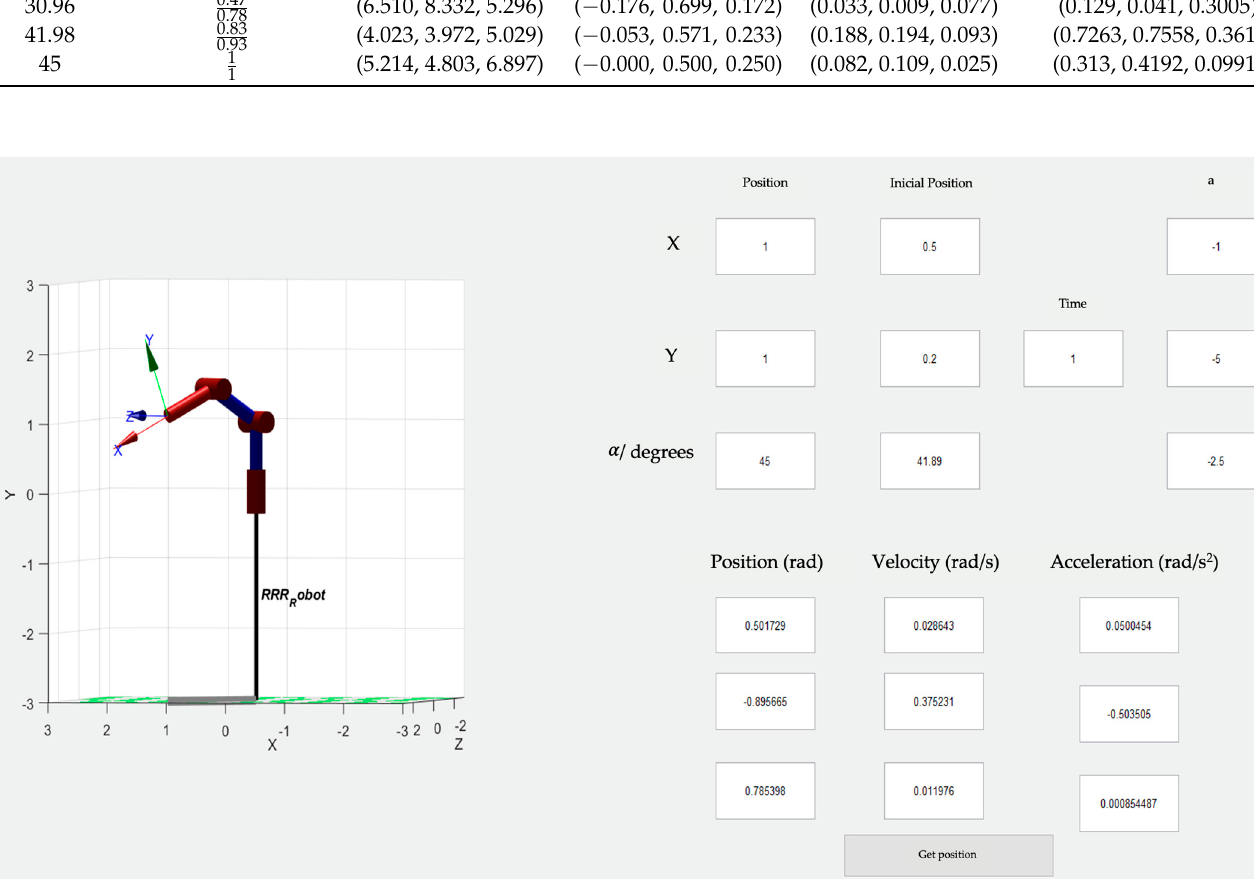
Table 1. Results of the trajectory planning in the first condition, the coordinate (𝑥 (cid:3043) , 𝑦 (cid:3043) ) is located in the first right triangle’s area.